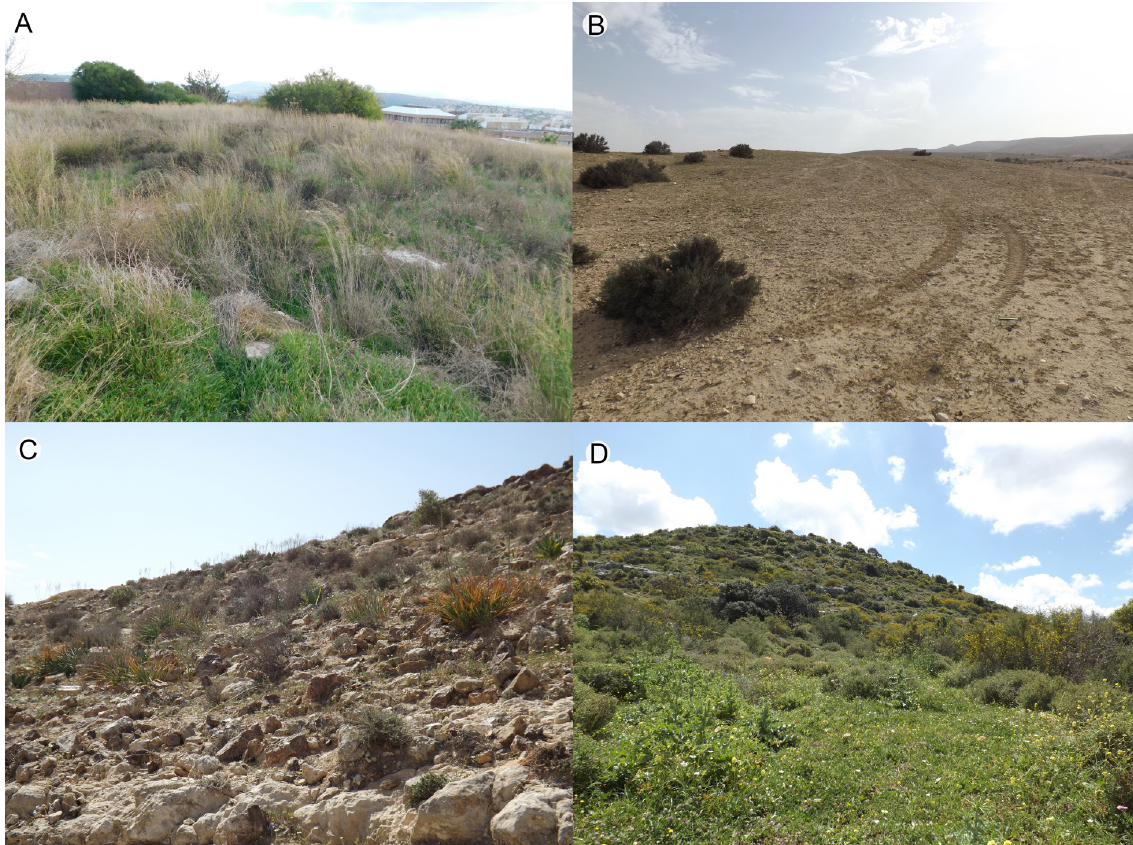
Fig. 21. Typical habitats. A . Mediterranean grassland, Karmiel. B . Desert loess plain, Yeruham. C . Desert rocky slope, Yeruham. D . Mediterranean dwarf scrub (batha), Yodfat. Photos by I. Armiach